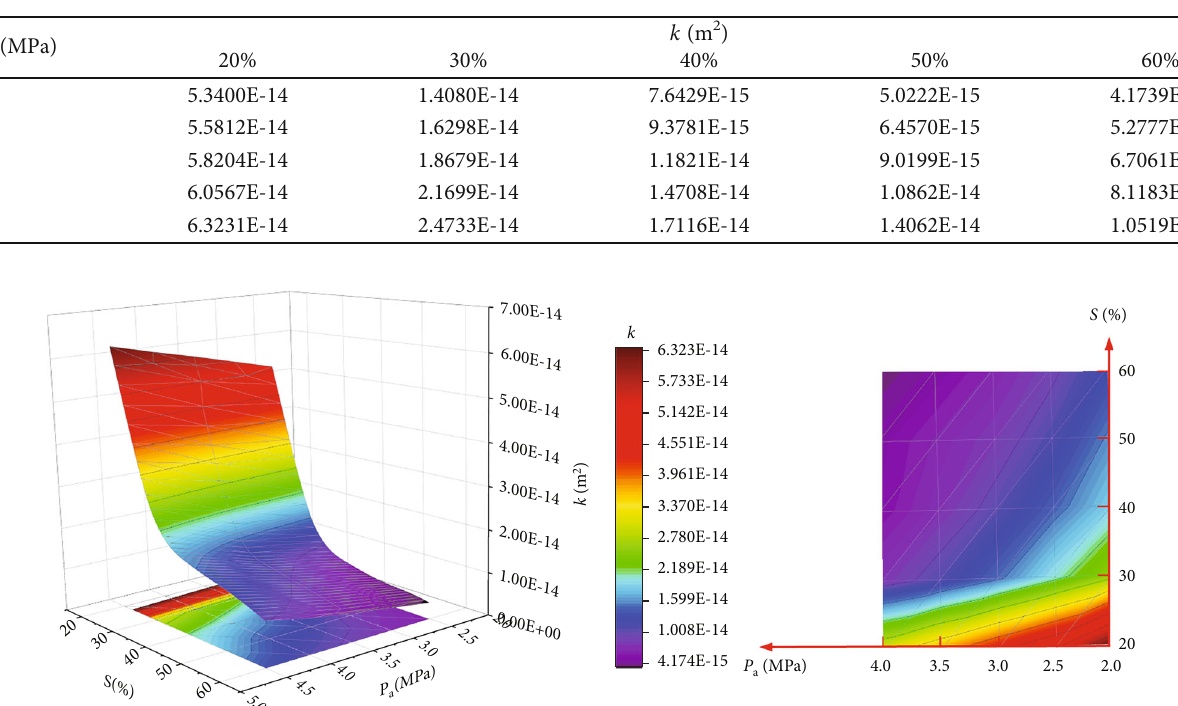
Figure 18: Variation surface of permeability k with axial pressure P